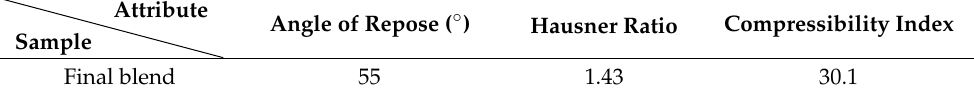
Table 2. Properties of the final